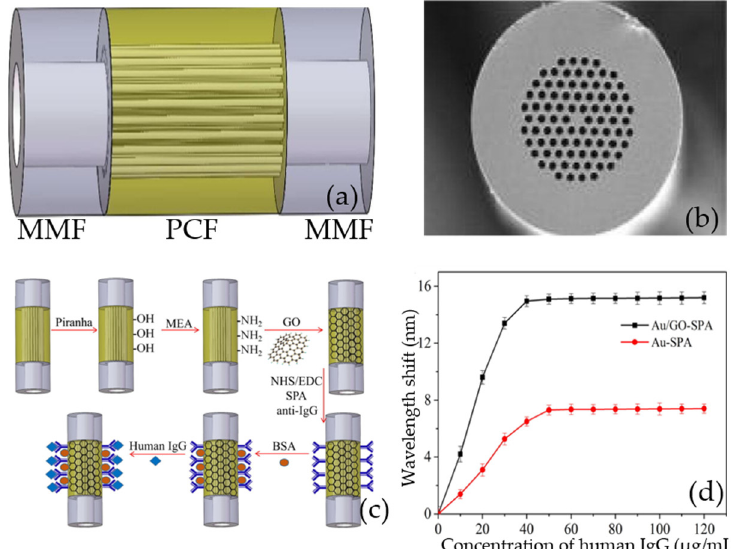
Figure 9. ( a ) The schematic diagram of MMF-PCF-MMF (multimode fiber-photonic crystal fiber- multimode fiber) sensor. ( b ) The end-face micrograph of PCF. ( c ) GO and SPA modified process for IgG immunoassay. ( d ) Goat anti-human IgG immobilized on the sensor surface. Error bars represent the standard deviation of three independent experiments. Reproduced from [107] with permission of Elsevier.